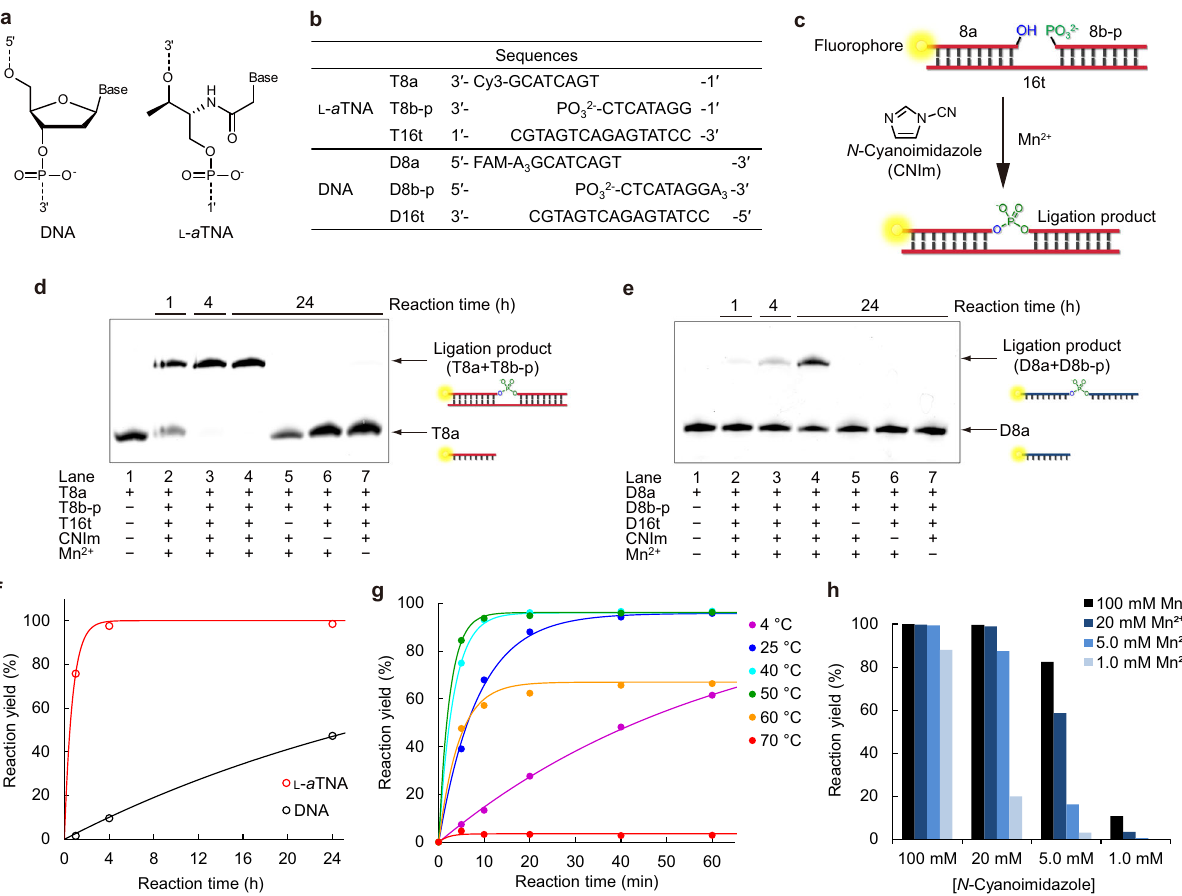
Fig. 1 Chemical ligation of L - a TNA and DNA. a Chemical structures of DNA and L - a TNA. b Sequences of 8-mer fragments and 16-mer templates. c Schematic illustration of the chemical ligation reaction. Denaturing PAGE analysis of d L - a TNA ligation reaction and e DNA ligation reaction. Lane 1, X8a as a marker; lane 2, reaction products after 1 h; lane 3, reaction products after 4 h; lane 4, reaction products after 24 h; lane 5, products after reaction in the absence of template; lane 6, products after reaction in the absence of CNIm; and lane 7, products after reaction in the absence of Mn 2 + . Conditions: [X8a] = 0.9 μ M, [X8b-p] = 1.1 μ M, [X16t] = 0 or 1.0 μ M, [NaCl] = 100 mM, [MnCl = 0 or 20 mM, [CNIm] = 0 or 20 mM, 4 °C. Source data are provided as a 2 ] Source Data fi le. f Chemical ligation yield of L - a TNA (red circles) and DNA (black circles) after indicated times of reaction. g Chemical ligation yields of L - a TNA at indicated temperatures. Conditions: [oligomers] = 1.0 μ M each, [NaCl] = 100 mM, [MnCl 2 ] = 20 mM, [CNIm] = 20 mM. Source data are provided as a Source Data fi le. h Ligation yields of L - a TNA at indicated concentrations of CNIm and Mn 2 + . Conditions: [T8a] = 0.9 μ M, [T8b-p] = 1.1 μ M, [T16t] = 1.0 μ M, [NaCl] = 100 mM 25 °C, 30 min. Source data are provided as a Source Data fi